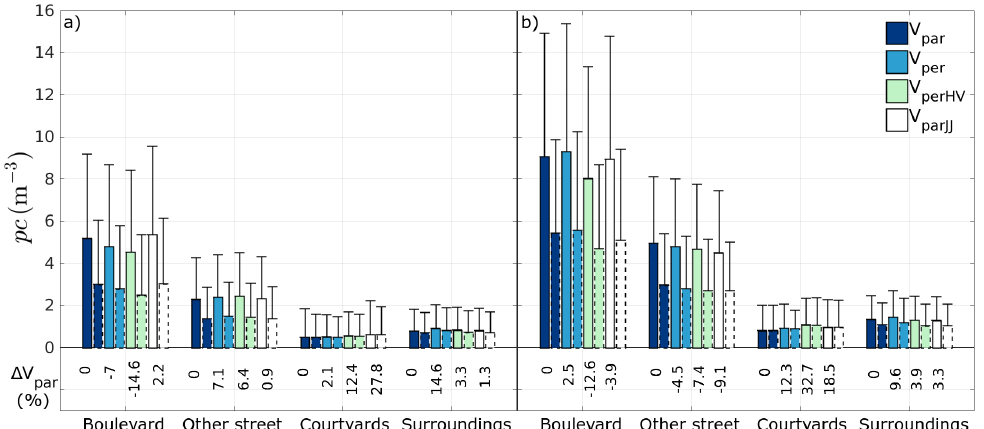
Figure 7. 40-min horizontal mean particle concentrations pc (m − 3 ) under the ( a ) general and ( b ) wintry inflow conditions separately above the boulevard, other street canyons, courtyards and surroundings at height z = 4 m (bars with solid lines) and z = 10 m (bar with dashed lines) for all runs. 90th percentile values are given with errorbars. The mean difference to the values in V par is given in percentages ( ∆ V par